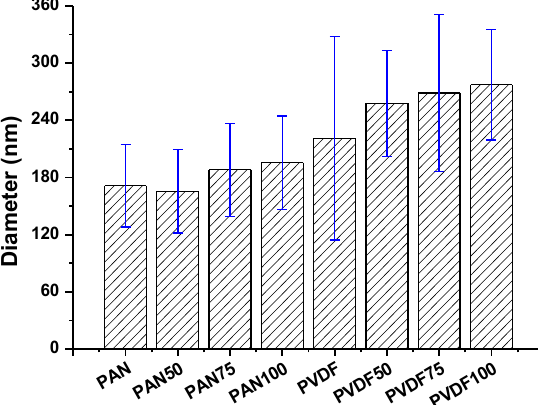
Figure 8. Fiber diameter of various multilayer nanofibrous membranes under different laminating pressures.